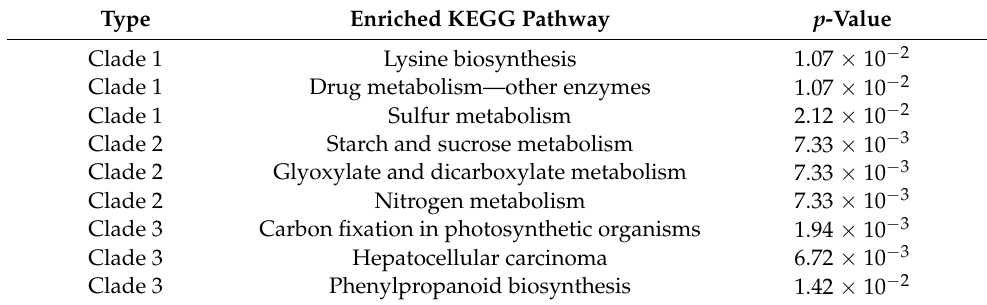
Table 1. The KEGG pathway enrichment analysis of SSGs in rice-infecting strains (Top3).